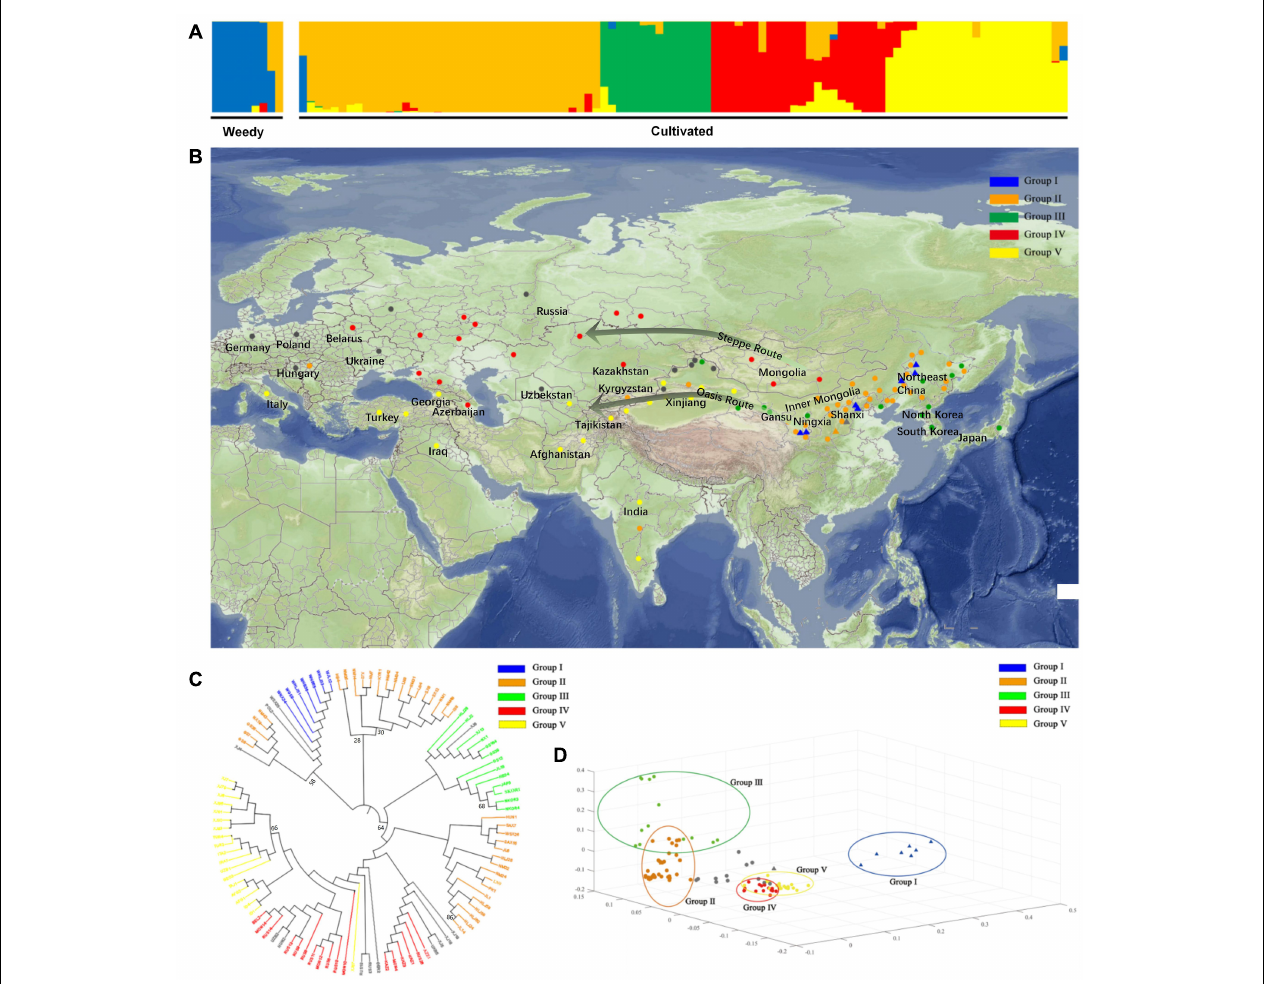
FIGURE 2 | Global distribution and population structure of the weedy and cultivated broomcorn millets. (A) Population structure analysis based on 106 accessions of weedy and cultivated broomcorn millets using ADMIXTURE with the optimal clustering number set at K = 5. Each accession is indicated by a vertical column and the colored portion (i.e., blue, orange, green, red, and yellow) in each column represents the proportion contributed from ancestral populations. (B) Geographic display and summary of ADMIXTURE analysis with the optimal clustering number set at K = 5 for 106 accessions of weedy and cultivated broomcorn millets throughout Eurasia. The cultivated accessions from India, Mongolia, and a few accessions from Russia could not be accurately located due to the lack of distribution information within these large areas and are therefore randomly placed inside their distribution areas. Each weedy accession and cultivated accession are represented by a filled triangle and a circle, respectively. Accessions with an admixture coefficient ≥ 80% are attributed to one of the Groups I to V based on ADMIXTURE analysis with each accession labeled with the color of group to which it belongs, while accessions with an admixture coefficient less than 80% are deemed as “mosaics” and colored with gray. (C) . The genealogical tree based on neighbor-joining (NJ) of the 106 accessions of weedy and cultivated broomcorn millets. The color of each accession is indicated by the group it belongs to with the “mosaics” marked as gray. The name of each accession starts with W to indicate a weedy accession, while others represent cultivated accessions. Most branches are supported by bootstrap values higher than 90 with six bootstrap values lower than 90 labeled next to the branches. (D) . Principal component analysis (PCA) of 106 accessions of weedy and cultivated broomcorn millets. Each weedy accession and cultivated accession are represented by a filled triangle and a circle, respectively. The color of each accession is indicated by the group it belongs to. The “mosaics” are marked as gray. The accessions belong to Group I to V are circled